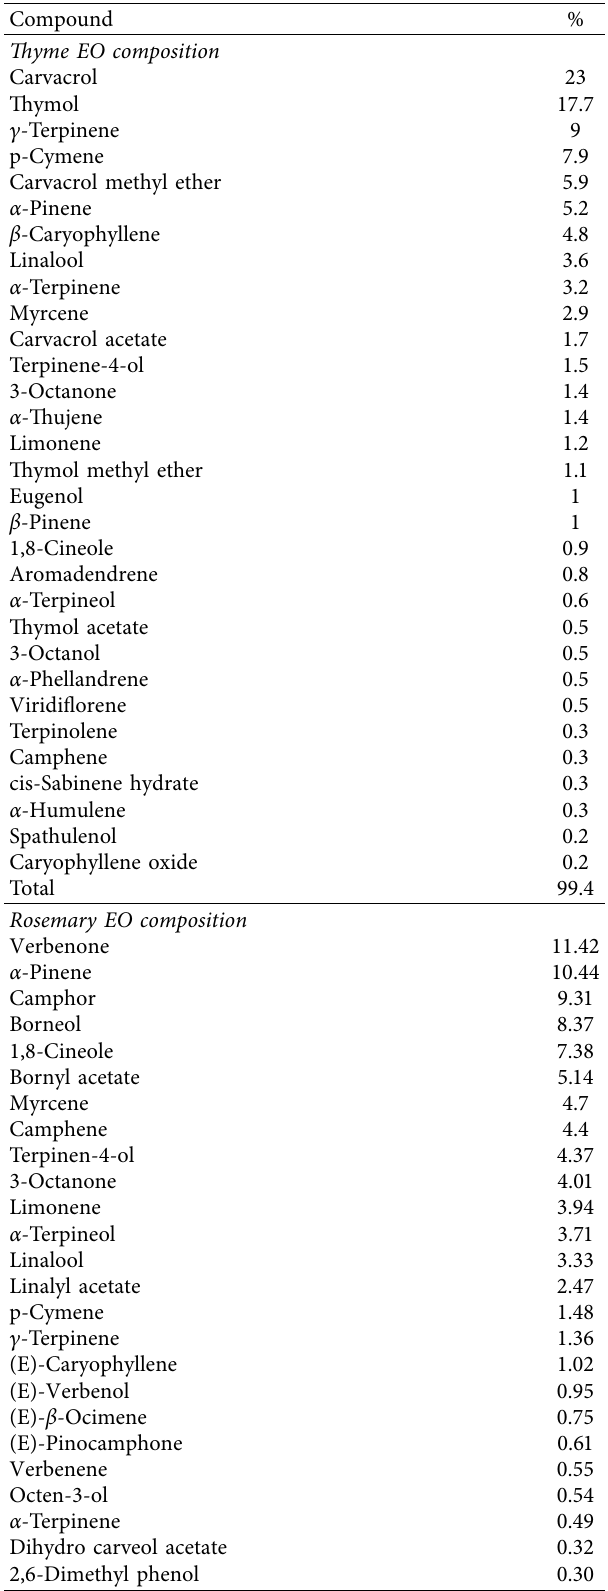
Table 1: Chemical composition of thyme and rosemary EOs used in this